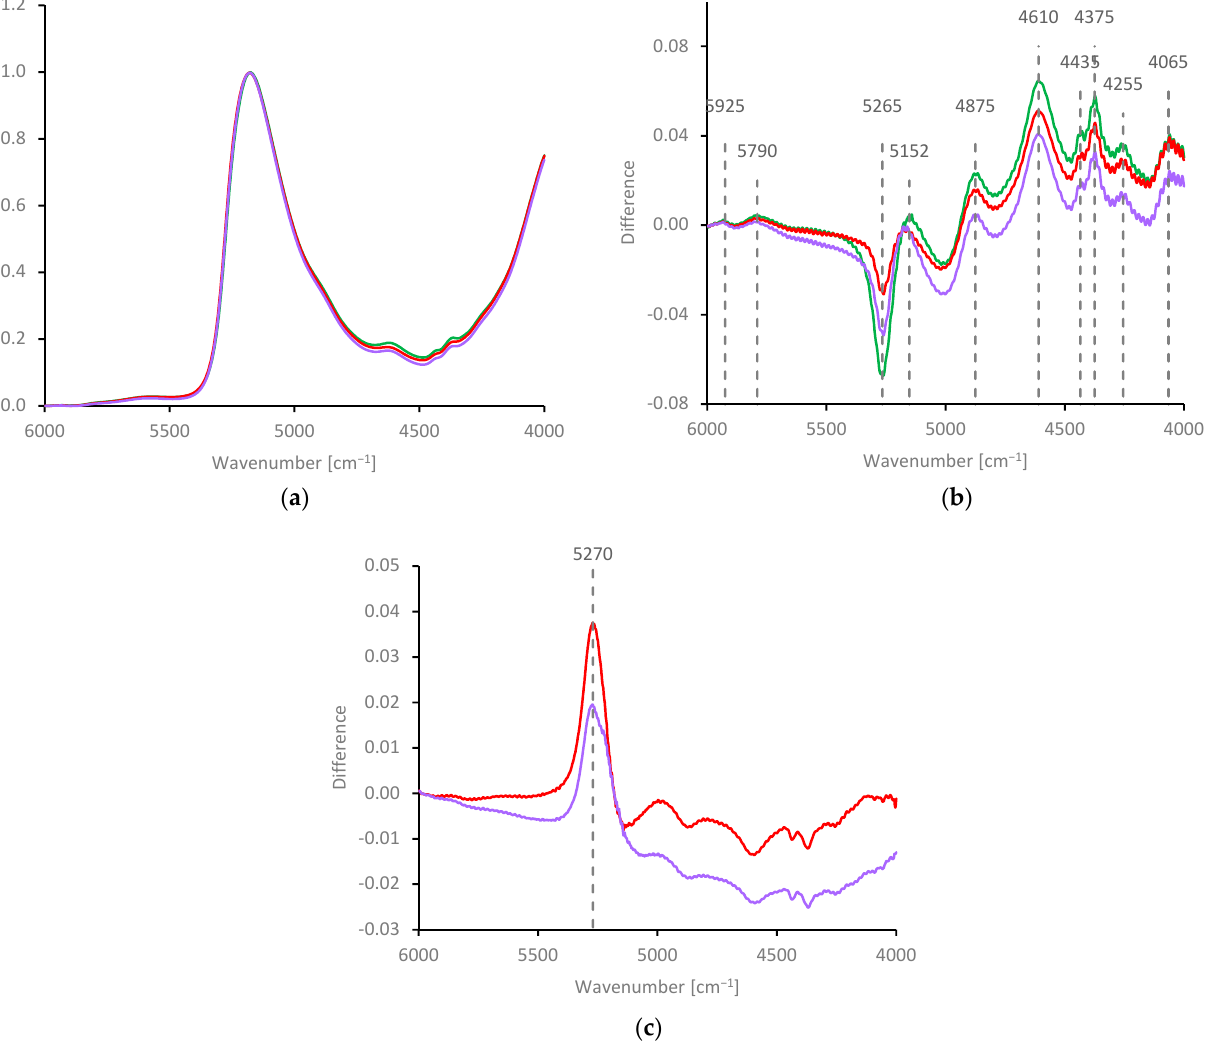
Figure 8. NIR spectra for silk fibroin: ( a ) NSF collected fresh from a silk gland and after gelation by freezing or heating; ( b ) difference spectra, from the data in ( a ) after subtracting a water spectrum; ( c ) difference spectra for, gelled specimens after subtracting the fresh NSF spectrum. All spectra were recorded at room temperature (22 °C) and the same colours are used throughout for specimens of fresh NSF (green) and gelled specimens produced by freezing (mauve, − 28 °C for 30 min) or heating (red, 82 °C for 5 min).